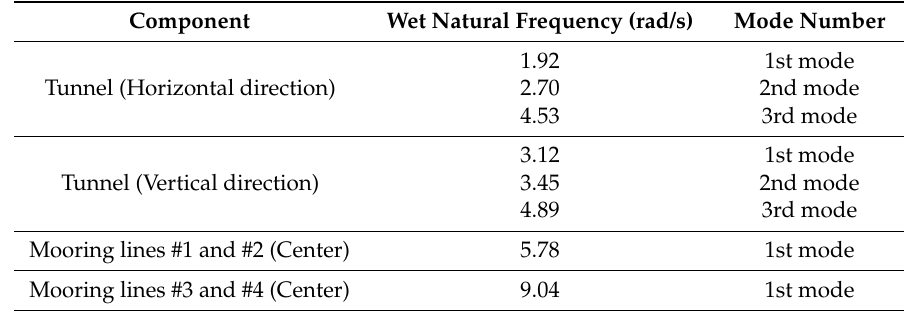
Table 2. Wet natural frequencies of the tunnel hydro-elastic responses coupled with mooring